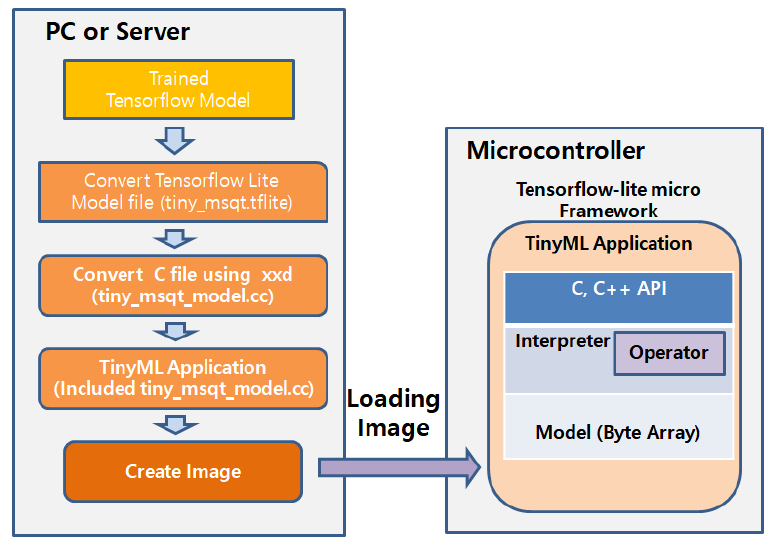
Figure 6. Deploying the mosquito detection TinyML application to